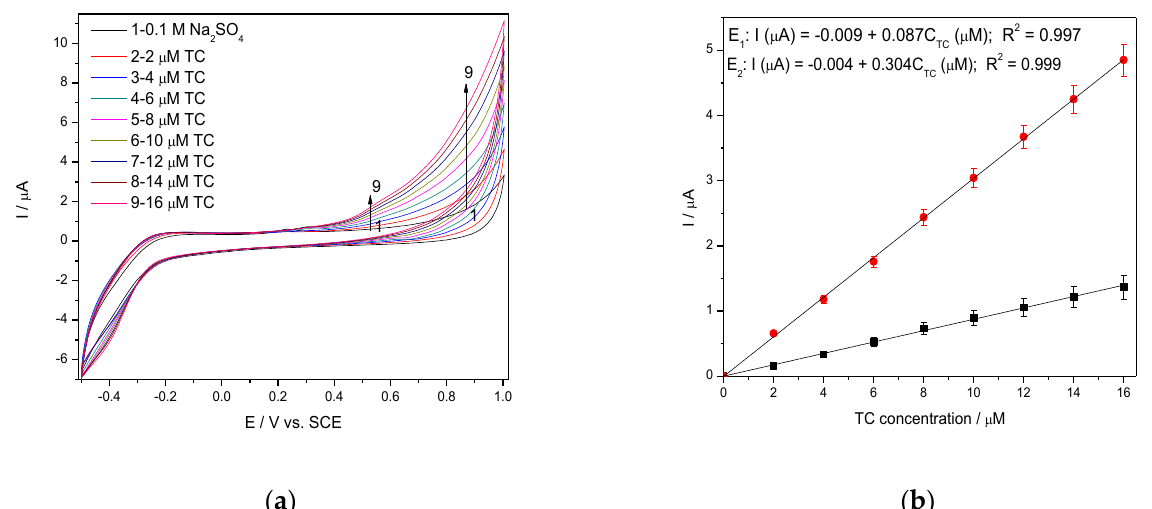
( b ) Figure 6. CVs recorded at the scan rate of 0.050 V·s − 1 in the presence of 0.282 mM Cl − in the supporting electrolyte: 0.1M NaOH ( a ) and 0.1M Na 2 SO 4 ( b ). The cyclic voltammograms recorded for the Ag/GO/BDD electrode in 0.1M Na 2 SO 4